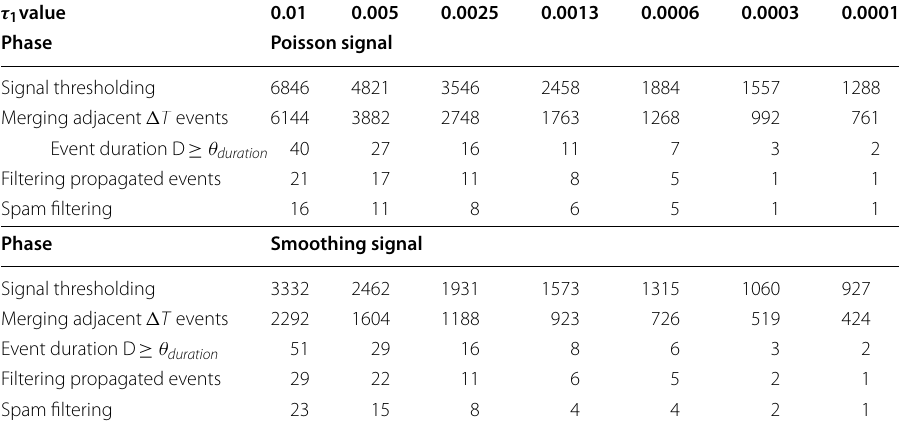
Table 4 Parameter selection: Poisson signal threshold ( τ 1 ) τ 1 value